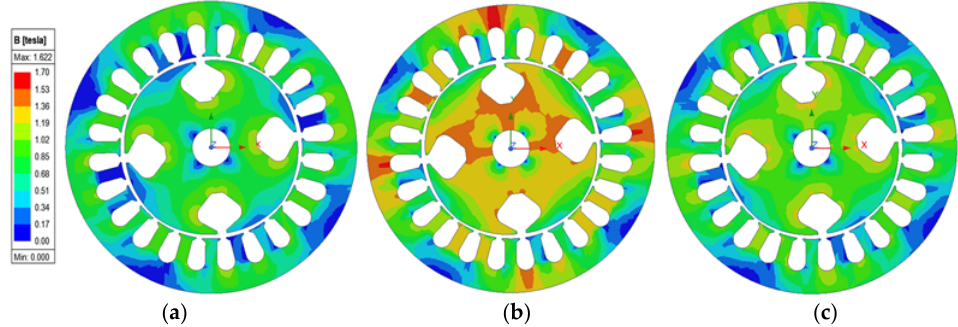
Figure 9. The flux density distribution of ( a ) reference machine, ( b ) proposed machine case 1, ( c ) proposed machine case 2.